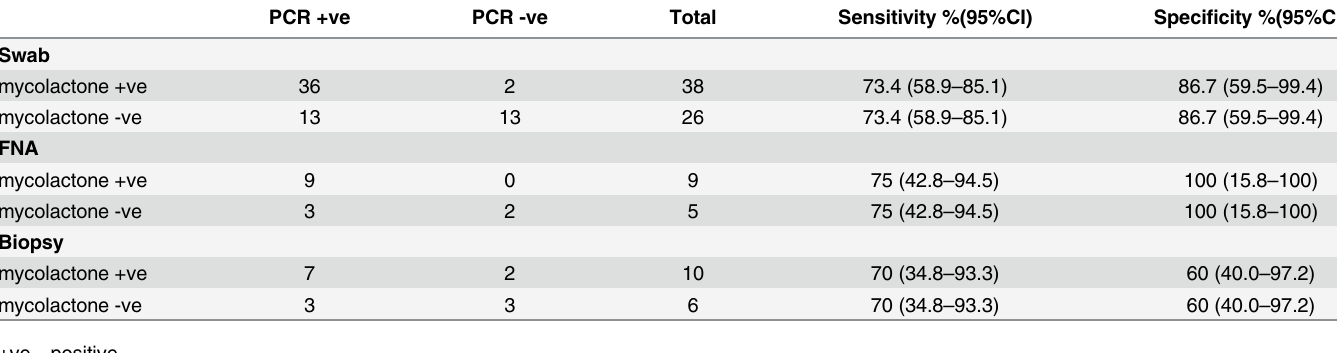
Table 3. Sensitivity and specificity by sample type of fluorescent TLC for mycolactone compared to PCR for